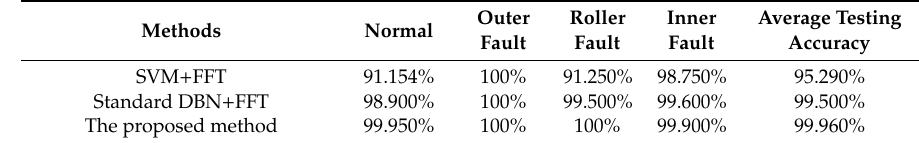
Table 9. Testing accuracy results of various methods.